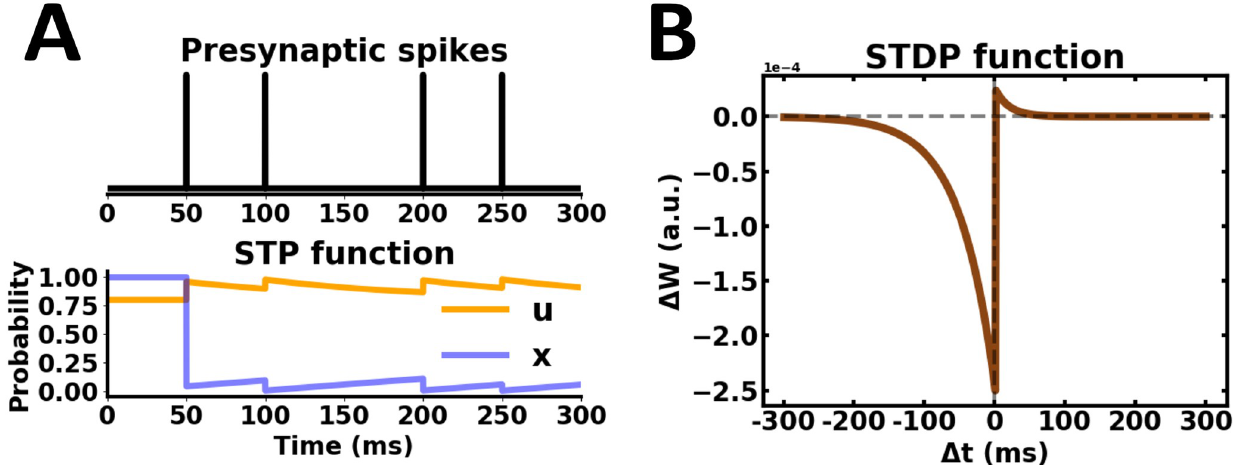
Fig 5. Synaptic plasticity profile. (A) STP dynamics from presynaptic spikes. Parameters: τ learning rule. Parameters: